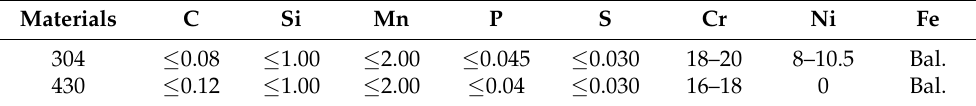
Table 1. The chemical composition of 304 and 430 stainless steel powders